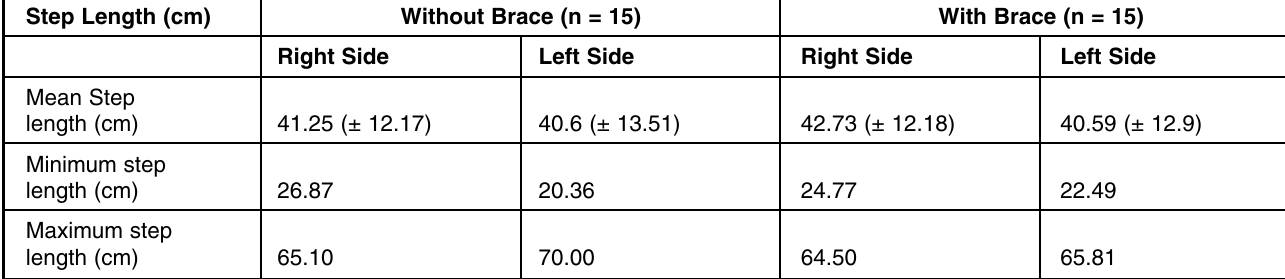
Table 2: Step Length with and without FECK Brace